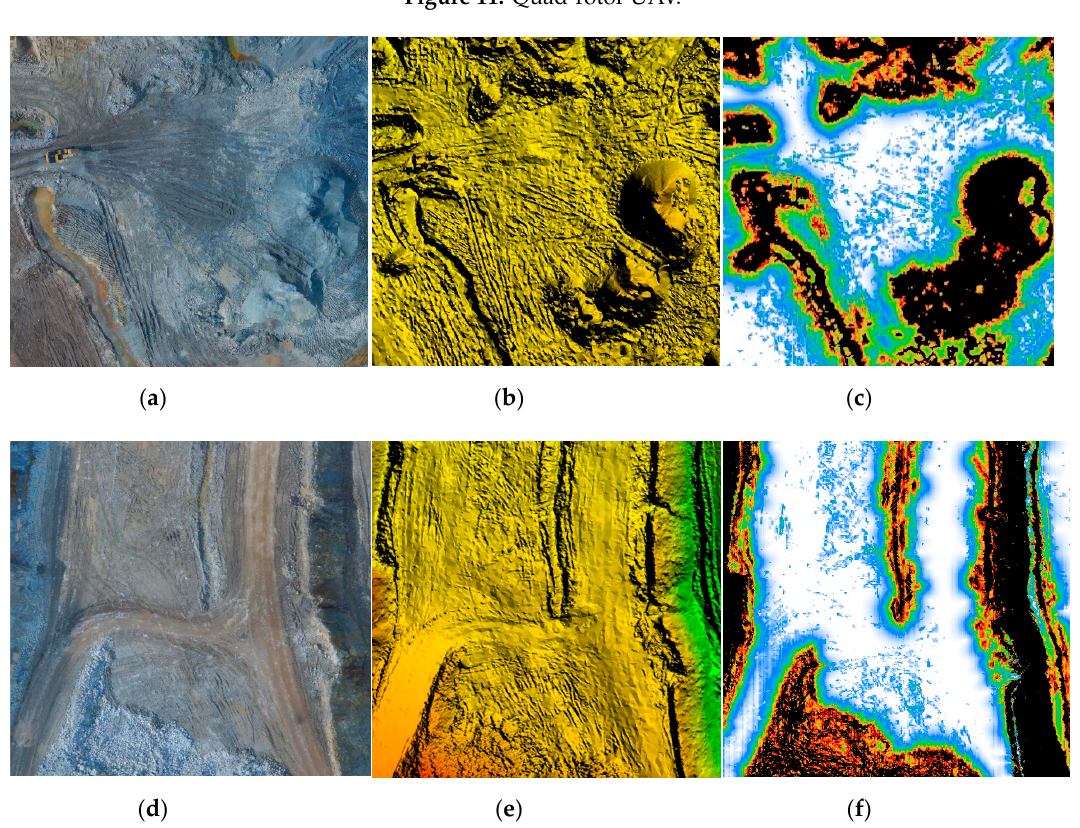
Figure 12. Schematic diagram of two cutting zone scenes. ( a , d ) are the orthophotographs; ( b , e ) are the DSM; ( c , f ) are the C-MAP.